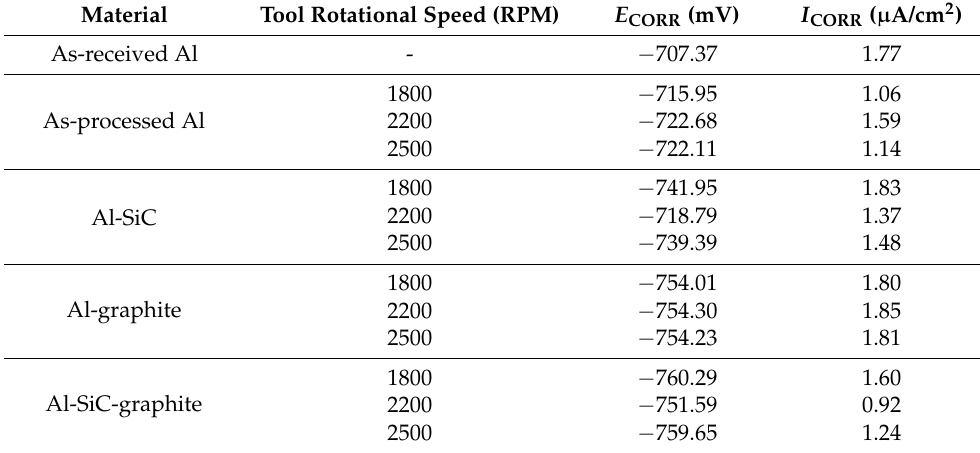
Table 1. The potentials and current densities obtained by Tafel extrapolarization analyses for as-received Al6061 and various composites fabricated at different tool rotational